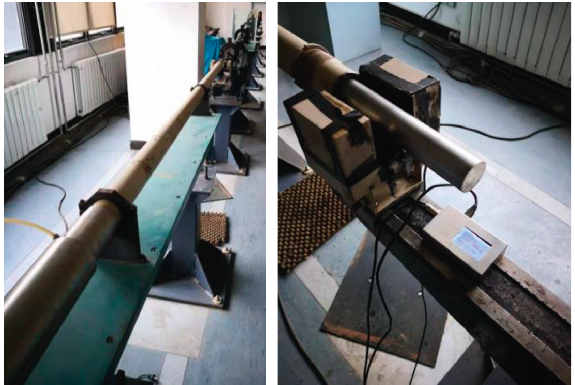
Figure 5: SHPB device and velometer.